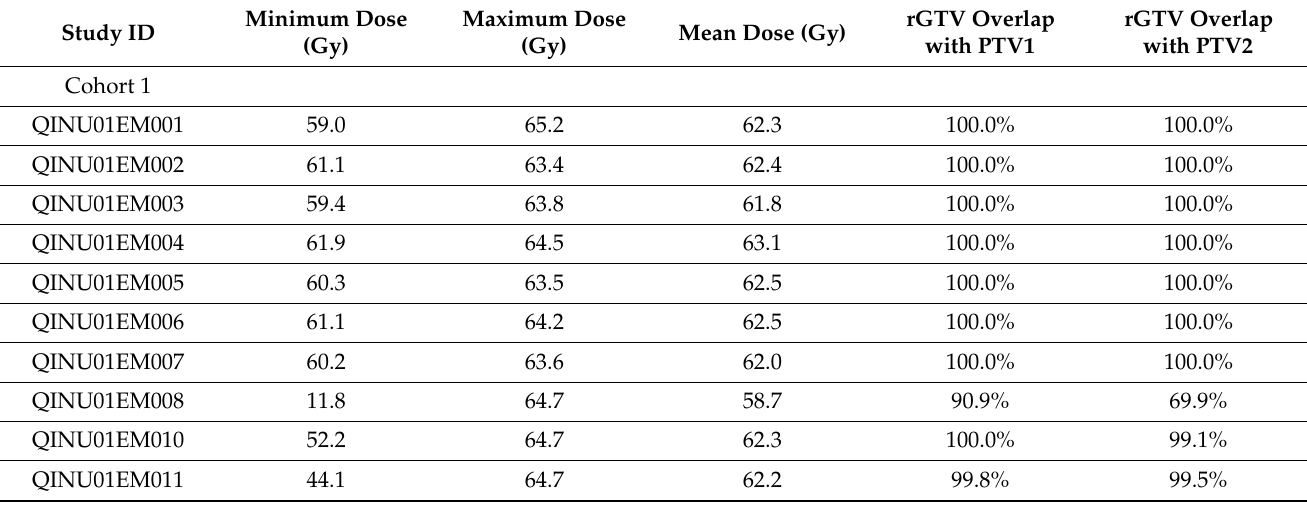
Figure 2. ( A ) Overall Survival (OS) Kaplan-Meier Survival Curves. The median OS for the control and belinostat cohorts was 15.8 and 18.5 months, respectively ( p = 0.53), for all patients. ( B ) Progression free survival (PFS) for all patients. The median PFS for control and belinostat cohorts was 9.0 months and 9.3 months, respectively ( p = 0.75). Table 2. Minimum, maximum, and mean radiation dose to recurrence volume (rGTV), overlap between rGTV and PTV1, and overlap between rGTV and